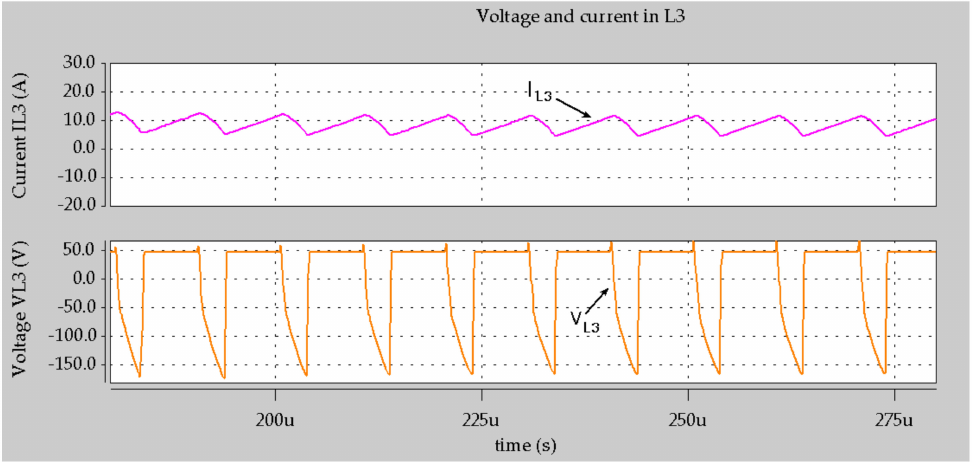
Figure 7. Simulation results for I L 3 and V L 3 . Simulation results for output voltage and current, V o and I o are shown in Figure 8 with DC (average) values V ODC = 193.39 V and I ODC = 5.52 A, getting an output power of P o = 1.067 kW. The ripple voltage obtained ∆ V o = 951 mV.